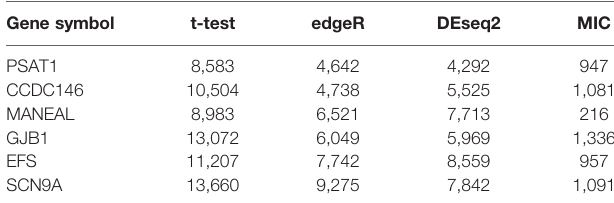
TABLE 3 | The ranking order by reference methods for the top gene of six datasets highlighted by normalized differential correlation (NDC). Gene symbol